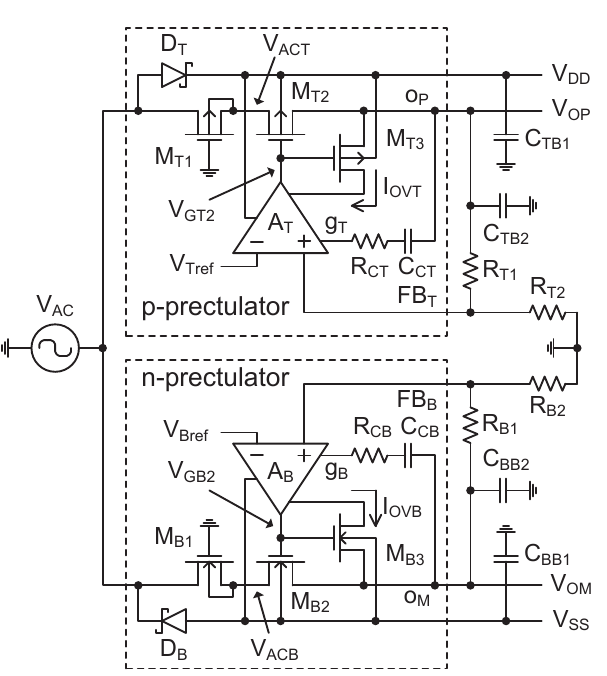
Fig. 1: Powering implant based on (a) conventional method Fig. 2: (a) conceptual prectulator design and auxiliary rectifier design based on (b) Schottky diode and (c) MOS realization